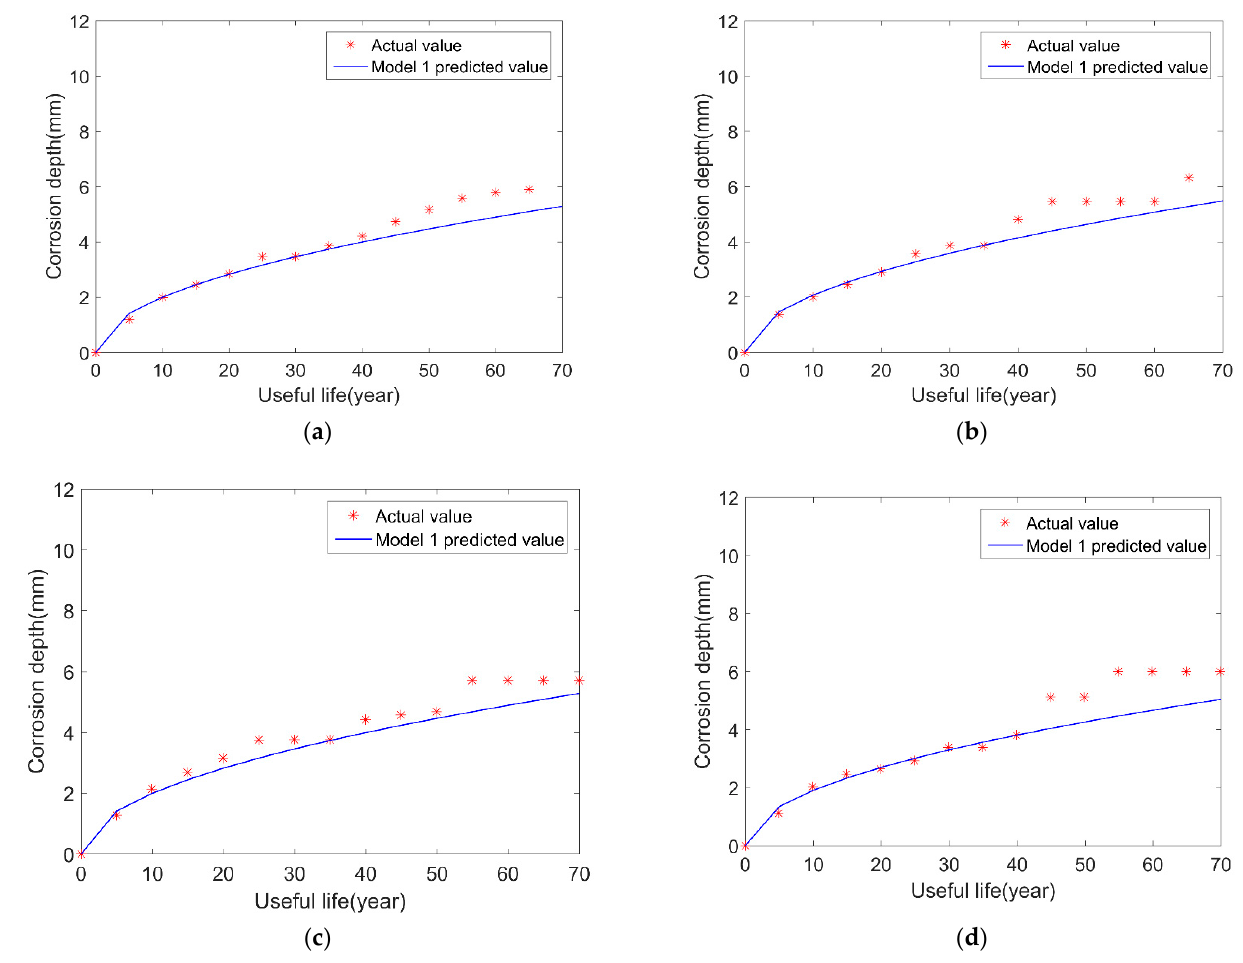
Figure 5. Comparison results of model 1 and the real results: ( a ) sample 1; ( b ) sample 2; ( c ) sample 3; ( d ) sample 4.